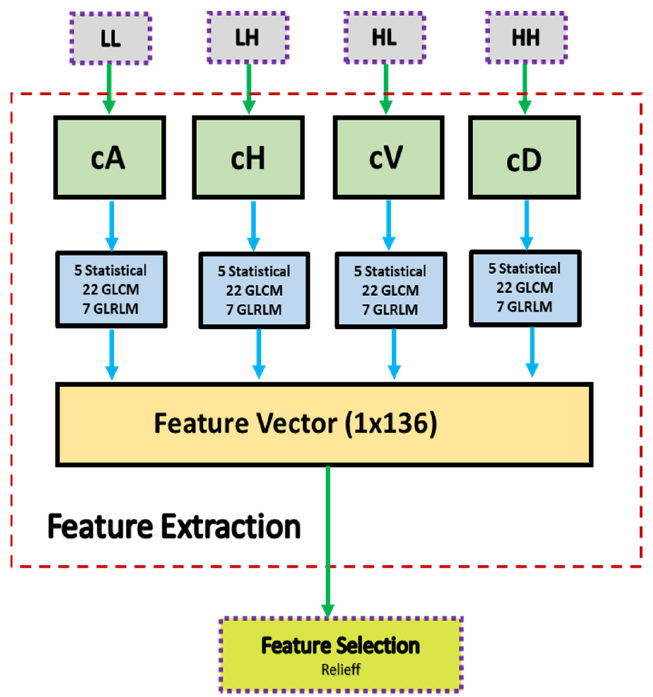
Figure 8. Block diagram of the feature extraction process.